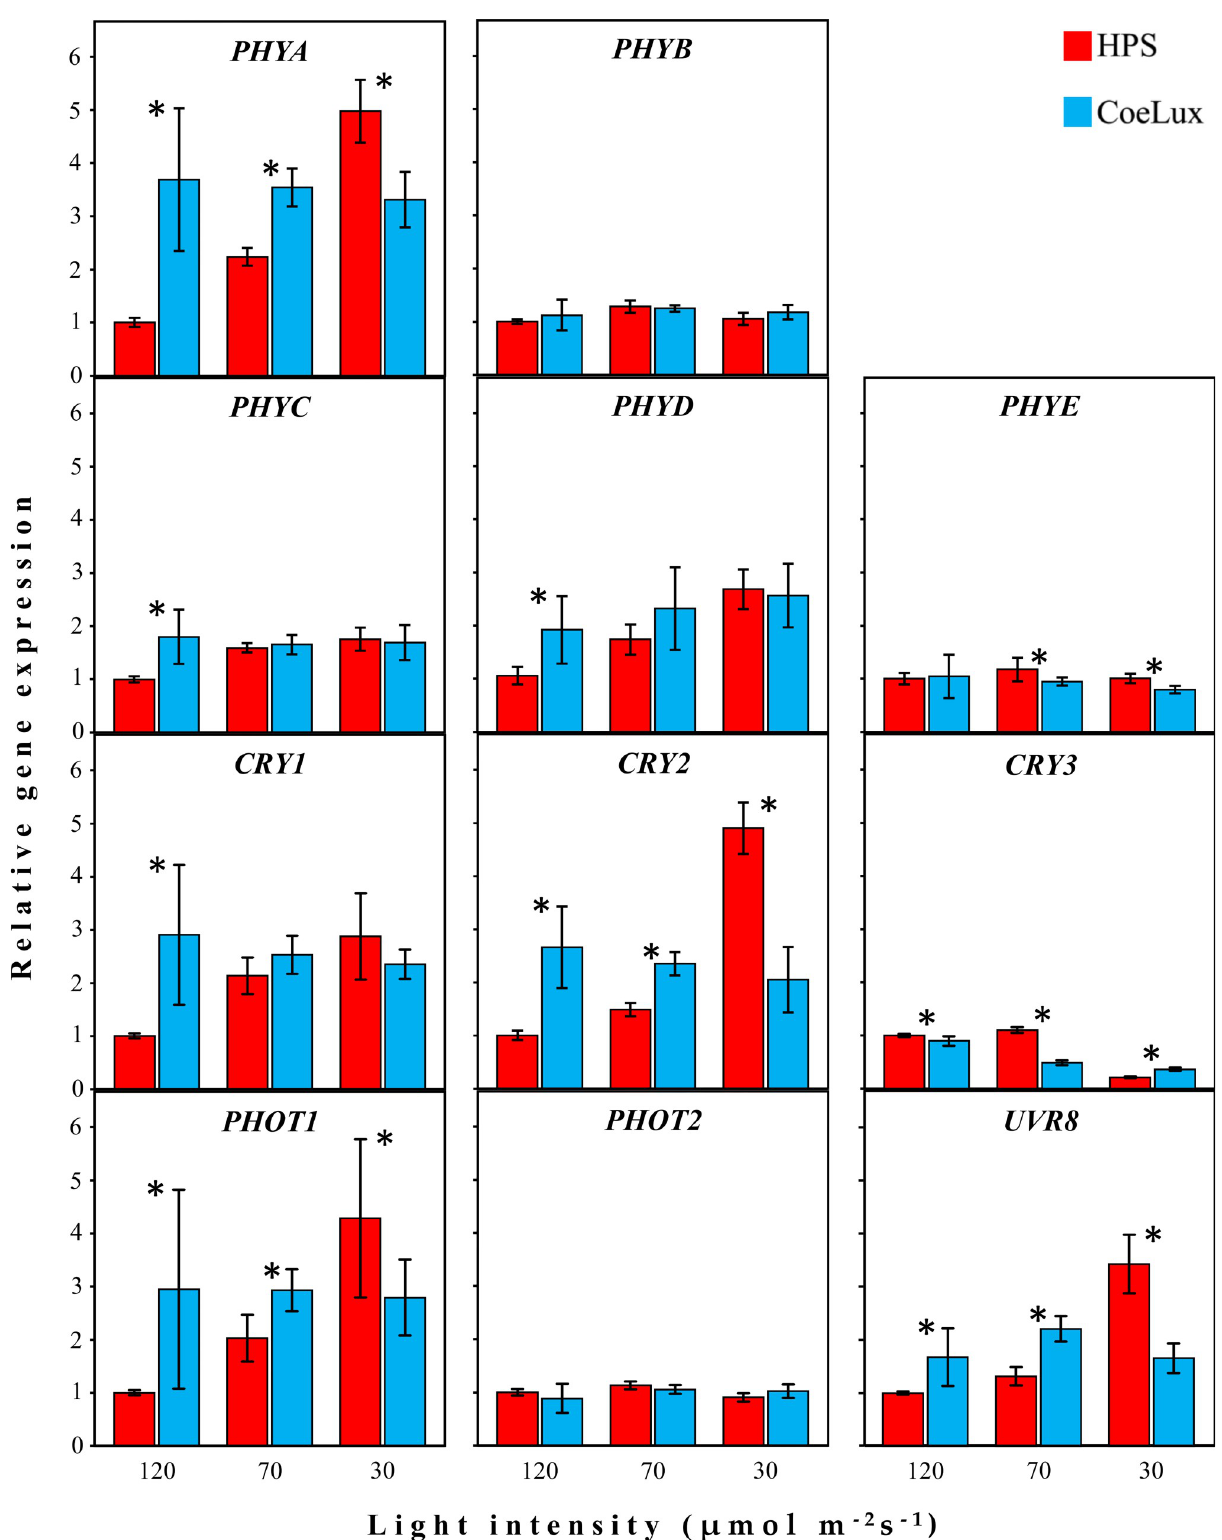
Fig 4. Relative expression of photoreceptors in the LTLT. The gene expression of the photoreceptors is relative to A . thaliana plants grown under the HPS light type at 120 μ mol m -2 s -1 , measured in 6-stage rosette leaves of plants growing under constant light treatment. Data represent the means of n = 2 biological repeats ± 95% CI. Asterisks represent statistically significant differences (p < 0.05) between plants grown under the two light treatments. https://doi.org/10.1371/journal.pone.0269868.g004 PLOS ONE | https://doi.org/10.1371/journal.pone.0269868 June 10,